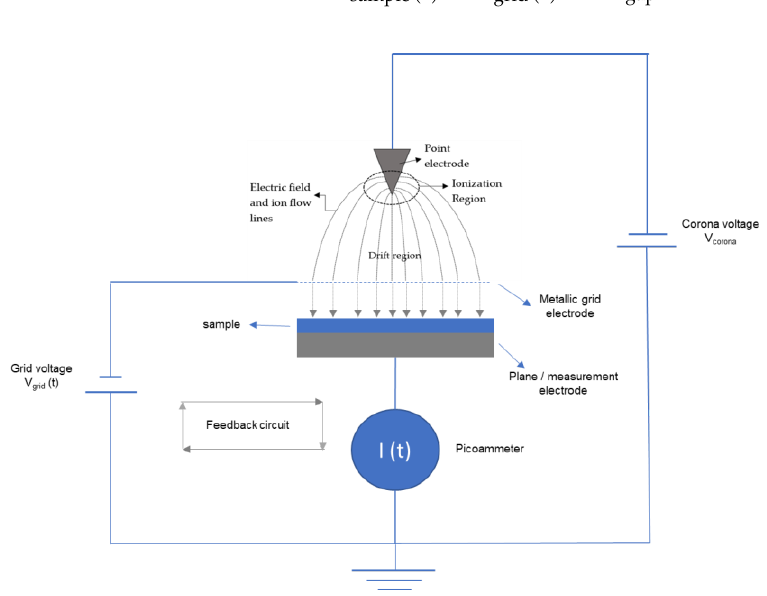
Figure 1. A corona triode employs three electrodes: the point, grid and plane/measurement elec- trodes, as indicated in the figure. In more advanced setups, the feedback circuit between the current I(t) flowing through the sample and the potential V grid (t) applied to the grid makes it possible to follow the sample surface potential buildup in real time during the charging process